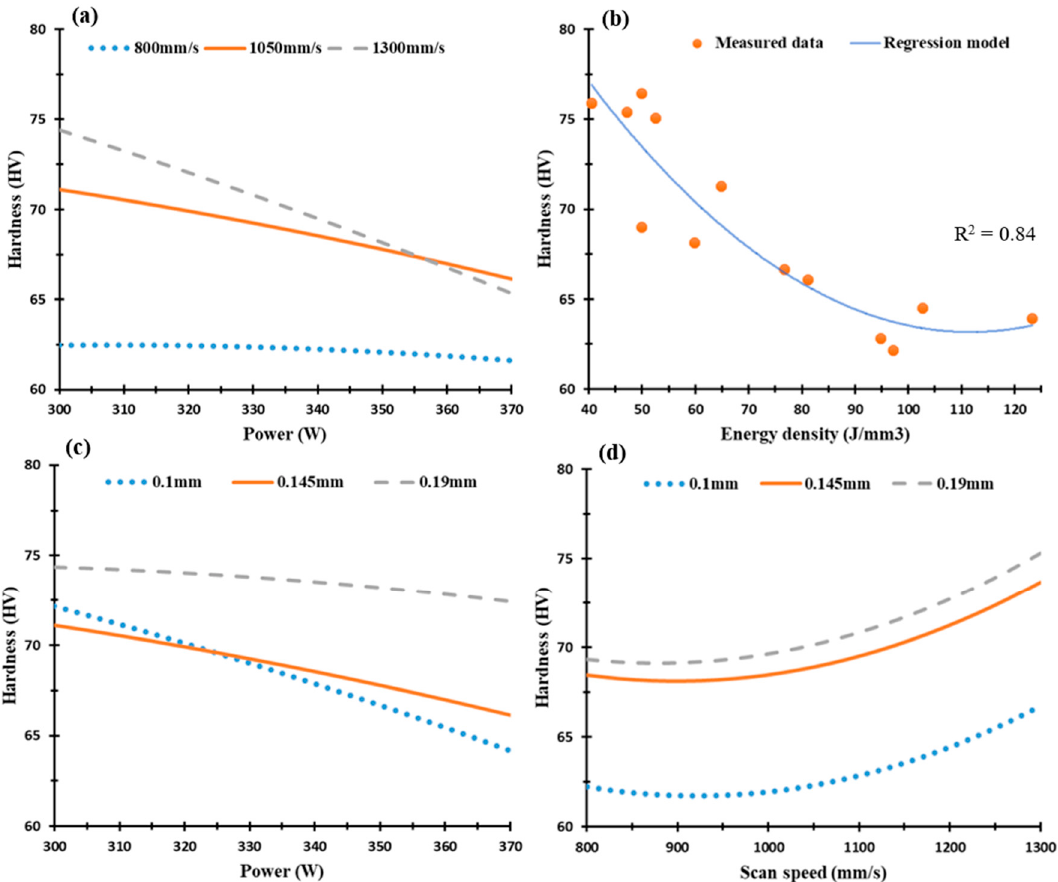
Figure 13. Microhardness of the as-built Al6061 samples along the XY plane vs. ( a ) Laser power (W); ( b ) Energy density (J/mm 3 ); ( c ) Hatch Spacing (mm), and ( d ) Scan speed (mm/s).